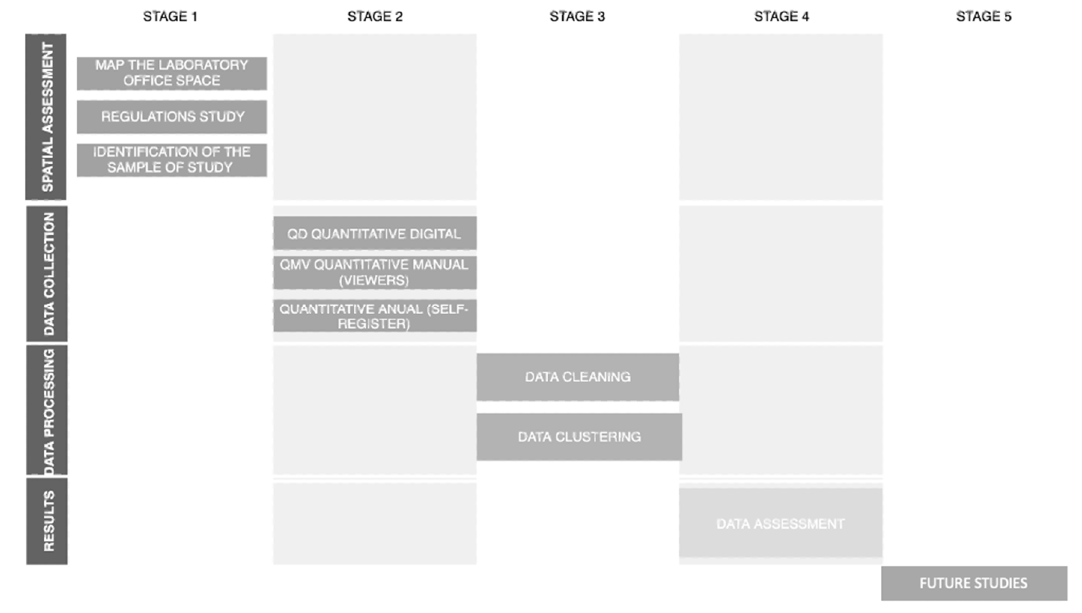
Figure 1. Project roadmap.